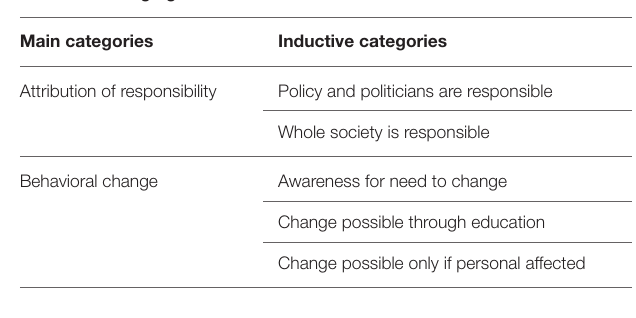
TABLE 4 | Role of the